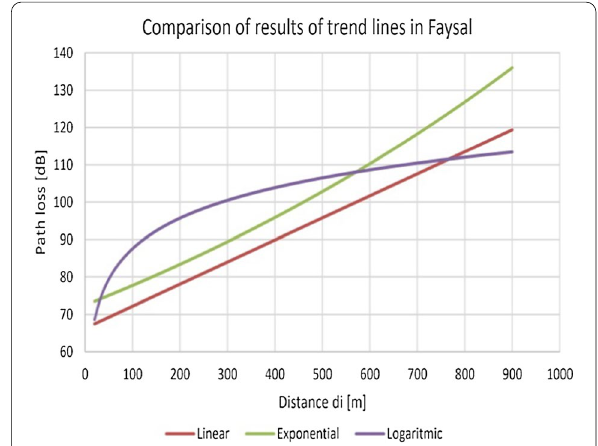
Fig.11 Comparison of results of trend lines in